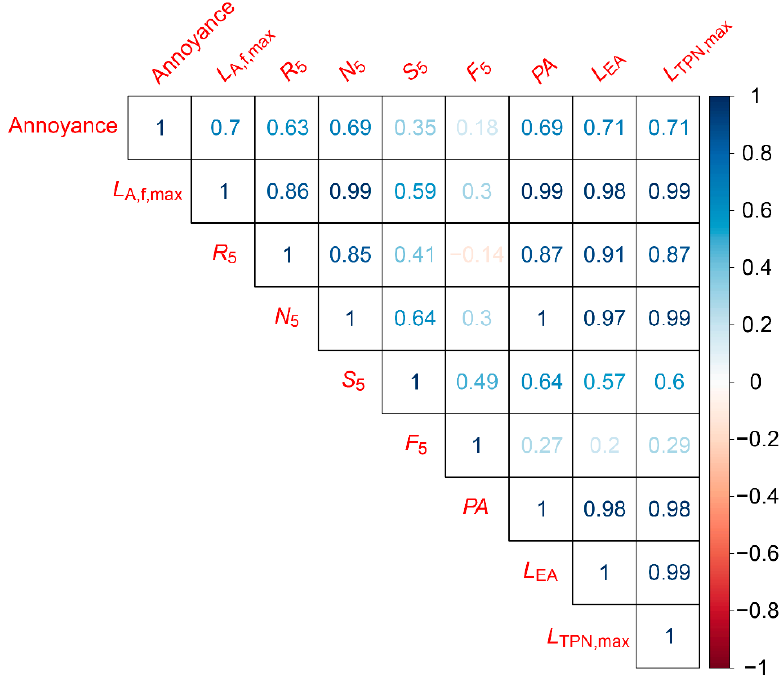
Figure 12. Correlation matrix between annoyance ratings and objective measurements for flyby noise events.